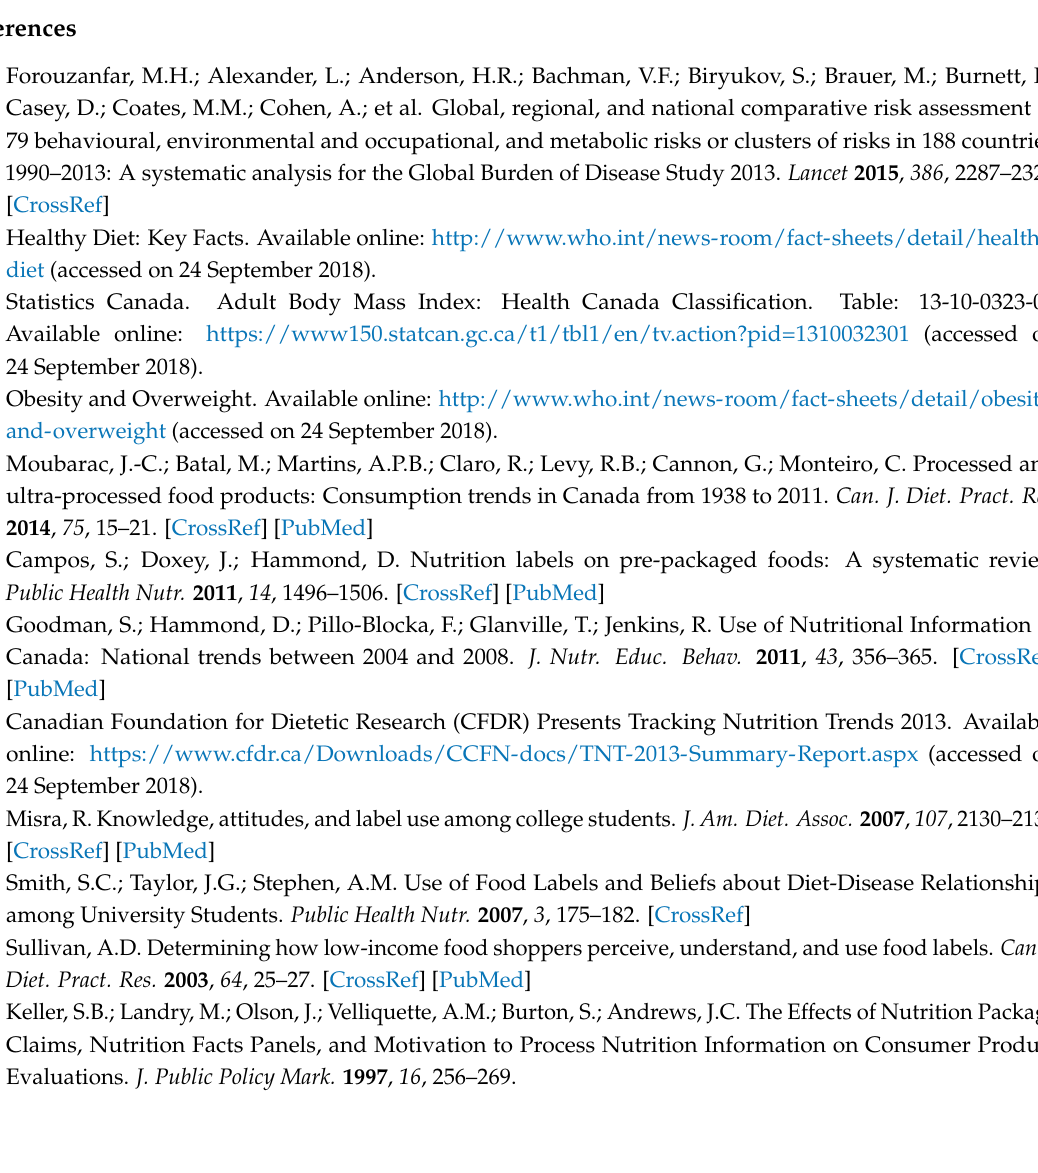
s1. Table S1: Socio-demographic characteristics (%, n ) by country ( n = 11,617), Table S2.: Odds (OR, 95%CI) of a correct response: Additional contrasts between FOP symbol designs ( n = 11,617).